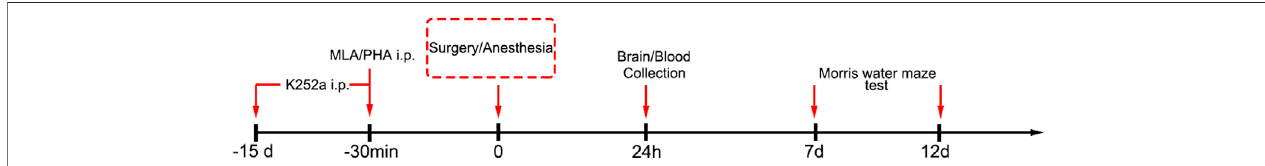
FIGURE 1 | Experimental protocol. Aged mice were pretreated intraperitoneally with an antagonist of TrkB receptor (K-252a) 15 days before anesthesia. 30 min priortoanesthesia, themice were administered intraperitoneally withan α 7nAChRagonist (PHA)and antagonist(MLA). Bloodand braintissuewerecollectedfor ELISA, Western blot, and immuno fl uorescence detection, 24 h later. Another cohort of aged mice were randomly allocated to the four groups for MWM test from days 7 to 12 after